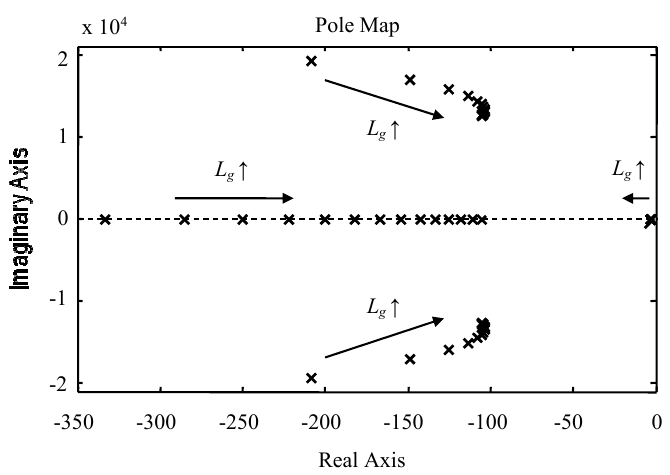
Figure 8. Pole map of the closed-loop system when L g varies from 0 to 13 mH. Energies 2017 , 10 , 336